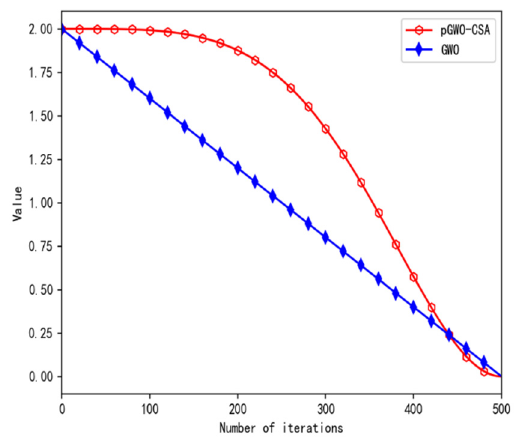
Figure 3. Iterative curve of parameter a .